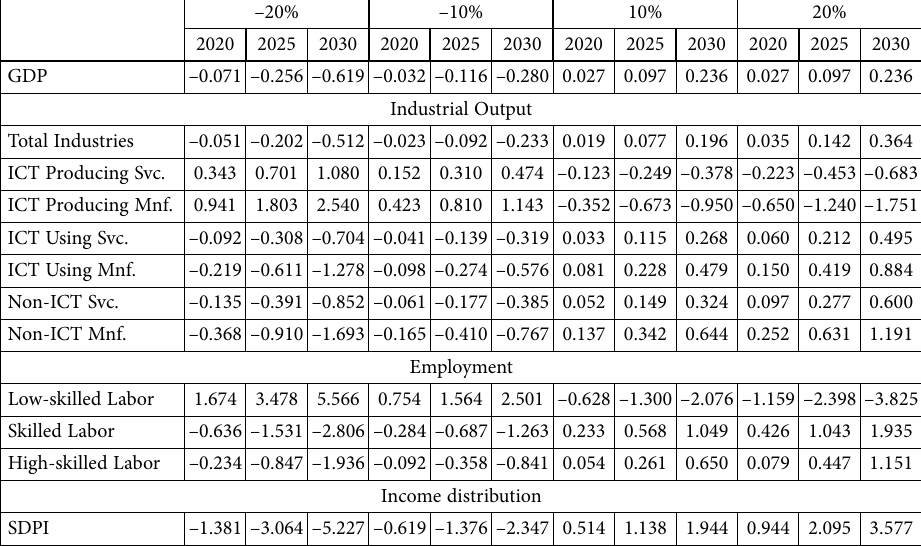
Table B4. Major variables under alternative elasticity of substitution between capital-skill composite and low-skilled labor ( s 4